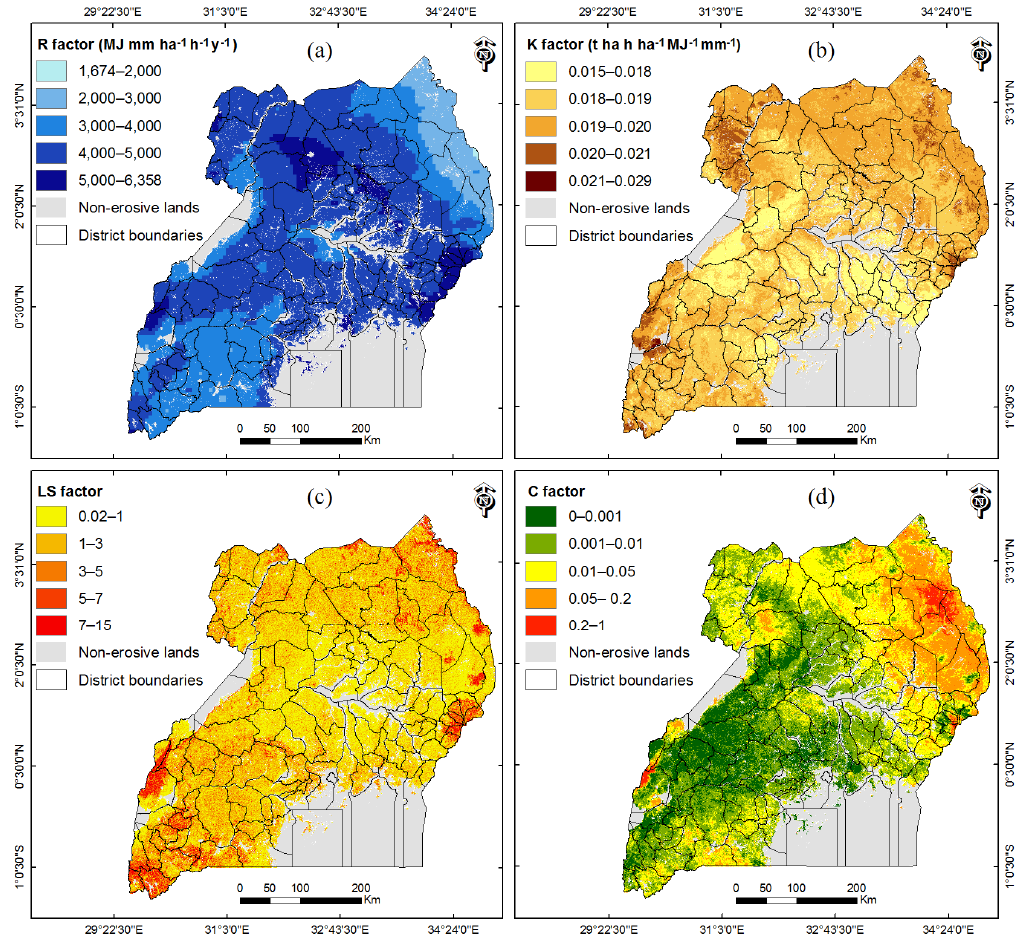
Figure 4. The Revised Universal Soil Loss Equation (RUSLE) factor maps: ( a ) rainfall ‐ runoff erosivity factor; ( b ) soil erodibility factor; ( c ) slope length and slope steepness factor; and ( d ) cover management factor. Table 1. P factor values for contouring, strip ‐ cropping, and terracing focusing on the slope classes. Slope (%)